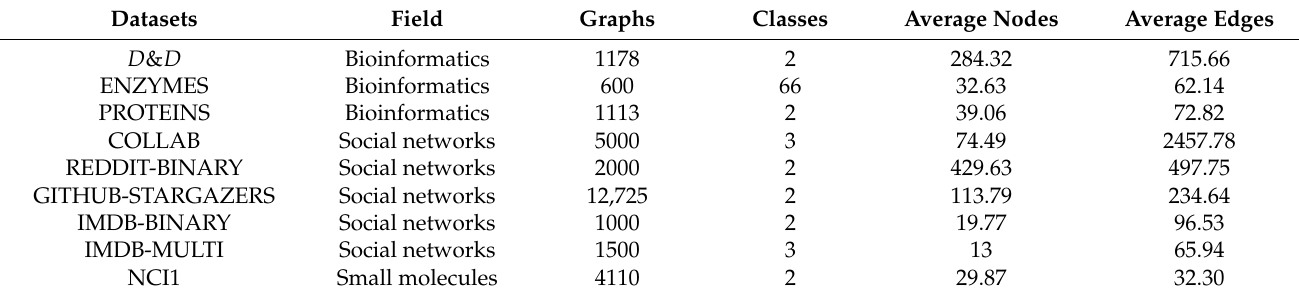
Table 1. Datasets